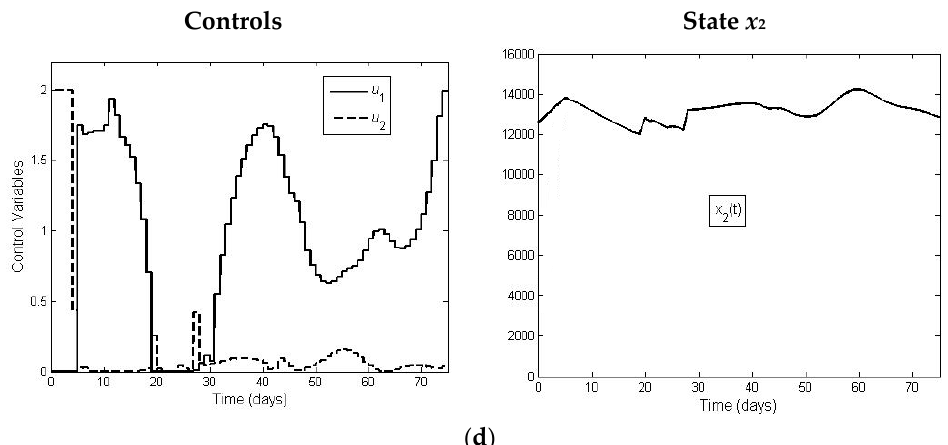
Figure 5. ( a ) Case 1: x 1 ( 0 ) = 12,000 and x 2 ( 0 ) = N ∗ = 12,500, ( b ) Case 2: x 1 ( 0 ) = 13,000 and x 2 ( 0 ) = N ∗ = 12,500, ( c ) Case 3: x 1 ( 0 ) = 14,000 and x 2 ( 0 ) = N ∗ = 12,500, and ( d ) Case 4: x 1 ( 0 ) = 15,000 and x 2 ( 0 ) = N ∗ = 12,500. In these cases, the values of the total cost are shown in Table 1. Table 1. Total costs for different initial values. Initial values (No. per hectare). Total cost (0) = 12000 and 𝑥 (0) = 12500 Flies 28.15€ + supplementary food 662 € 𝑥 (cid:2869) (cid:2870)